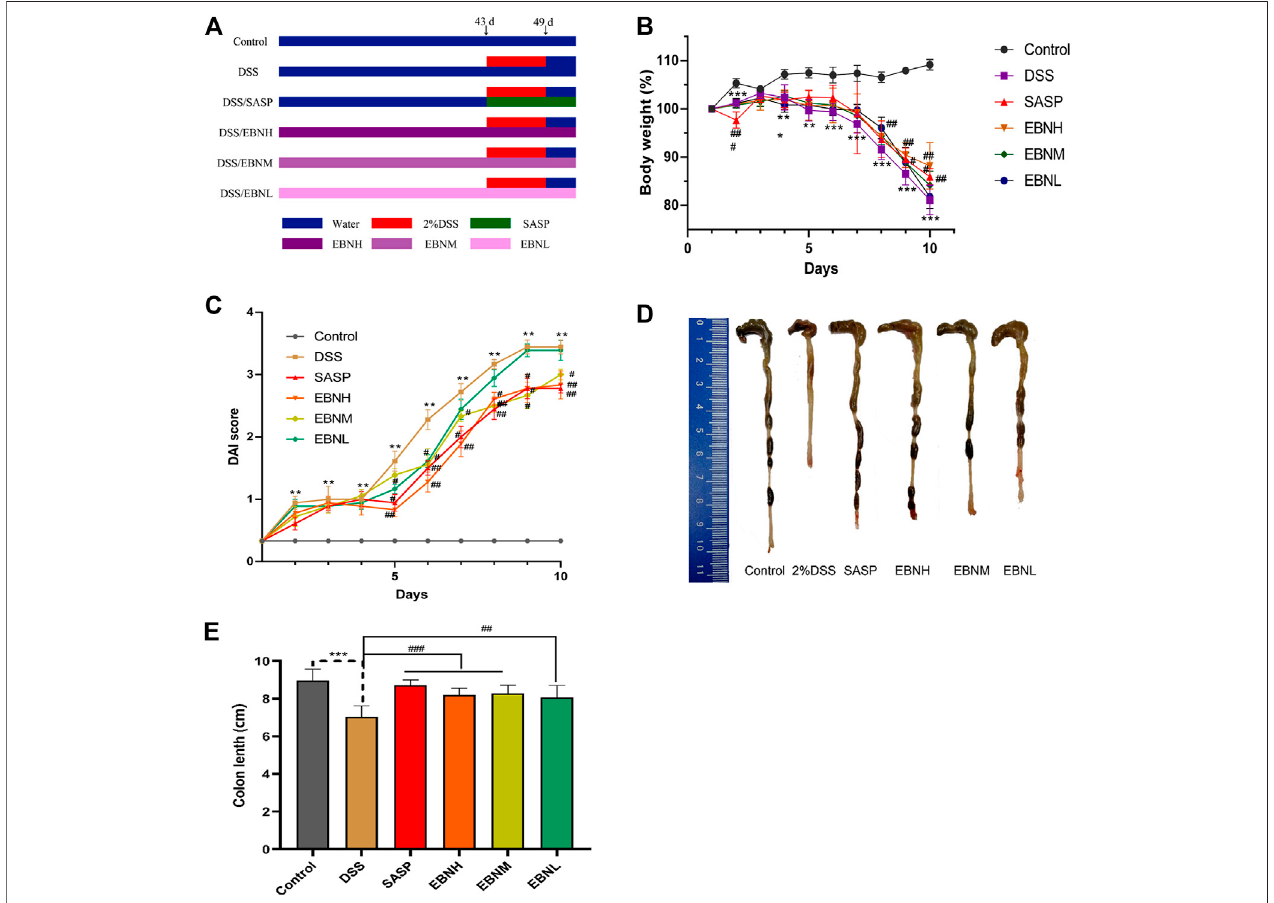
FIGURE 1 | Effects of EBN pretreatment on the clinical symptoms of DSS-induced colitis in C57BL/6J mice. (A) Schematic showing the experimental dosing design. (B) Effect of EBN on body weight during the modeling period of colitis induced by DSS. (C) Effect of EBN on the disease activity index (DAI) of colitis induced by DSS. (D,E) Effect of EBN on colon length in mice with colitis induced by DSS. ** P < 0.05 and *** P < 0.001 compared with the control group; # P < 0.05, ## P < 0.01 and ### P < 0.001 compared to the DSS group ( x ± S , n (cid:2) 6).